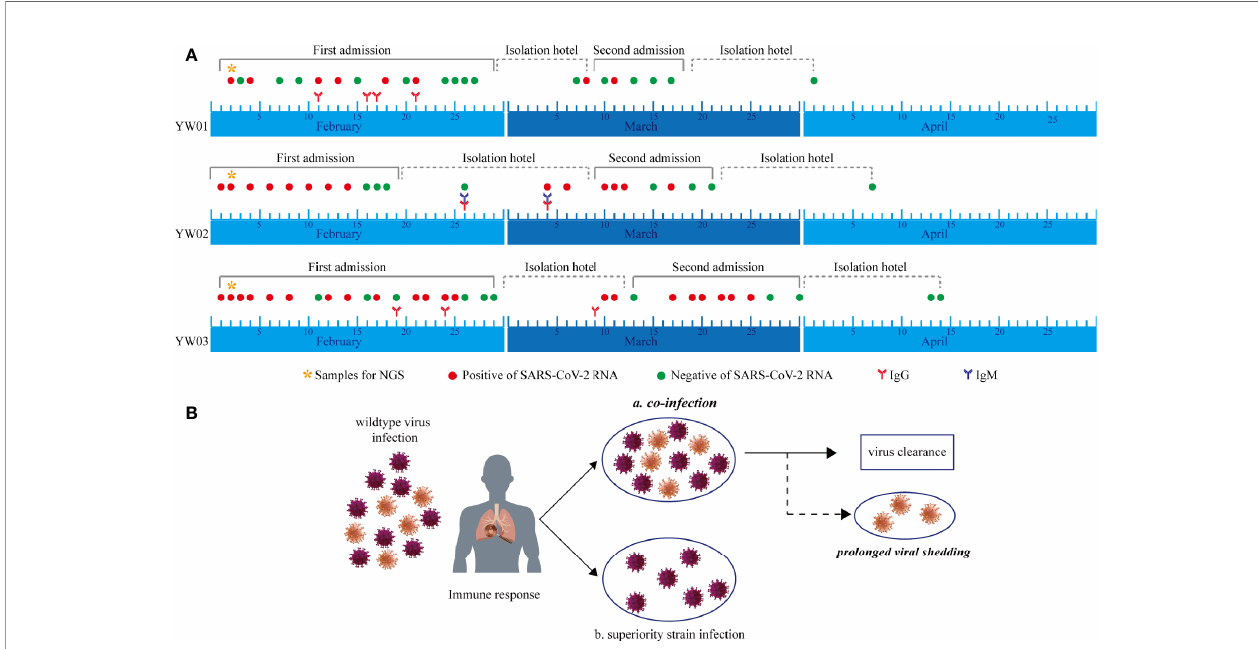
FIGURE 2 | Timeline during the whole course of COVID-19, including fi rst and second episodes. (A) Serial SARS-CoV-2 RNA testing, anti-SARS-CoV-2 IgM/IgG, and specimens for NGS were performed. CT, computed tomography; RNA, ribonucleic acid; NGS, next-generation sequencing; IgM, immunoglobulin M; IgG, immunoglobulin G; SARS-CoV-2; severe acute respiratory syndrome coronavirus 2; COVID-19, coronavirus disease 2019. (B) Hypothesis of haplotype or quasi- species co-infection of